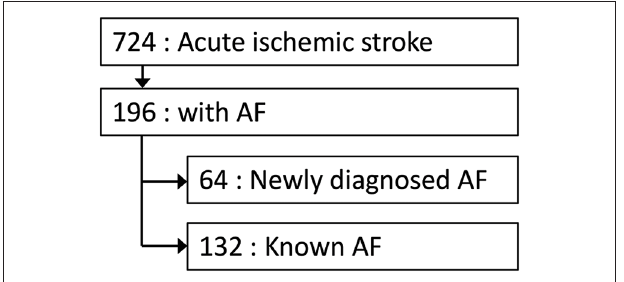
FIGURE 1 | Flow chart for study population. AF indicates atrial fibrillation.